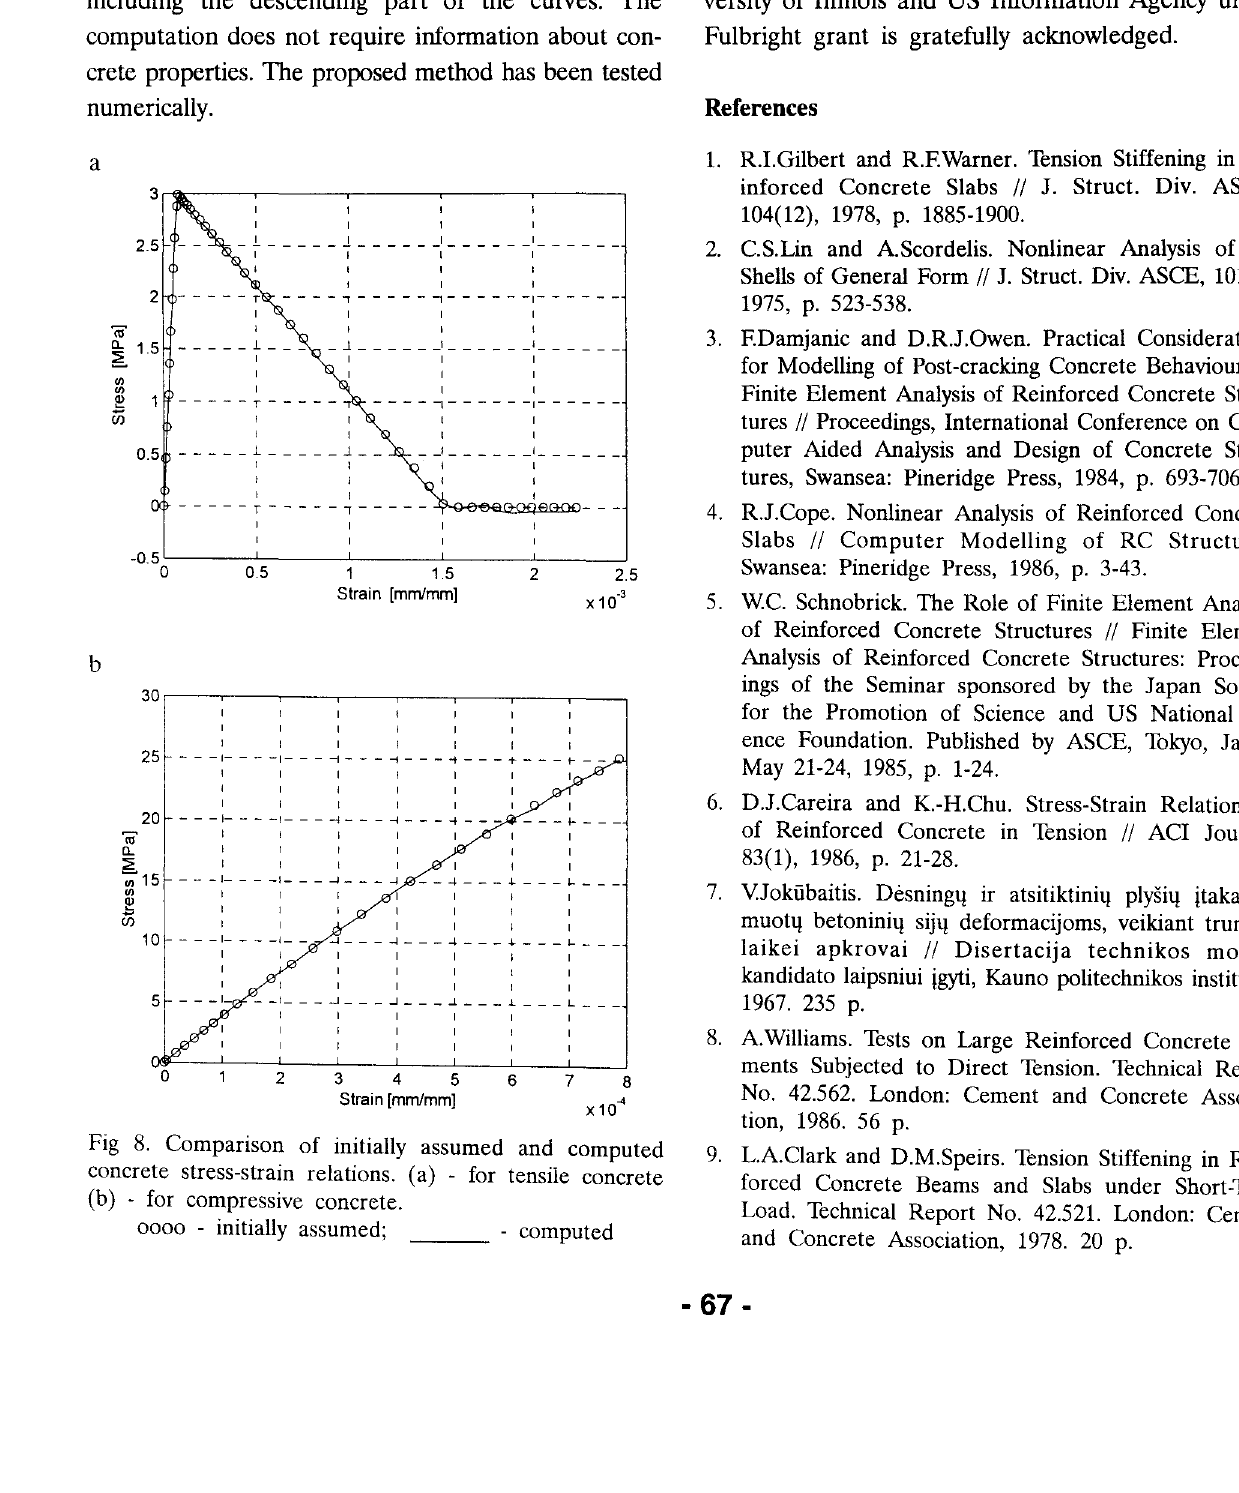
Fig 8. Comparison of initially assumed and computed concrete stress-strain relations. (a) - for tensile concrete (b) - for compressive concrete. oooo - initially assumed; -